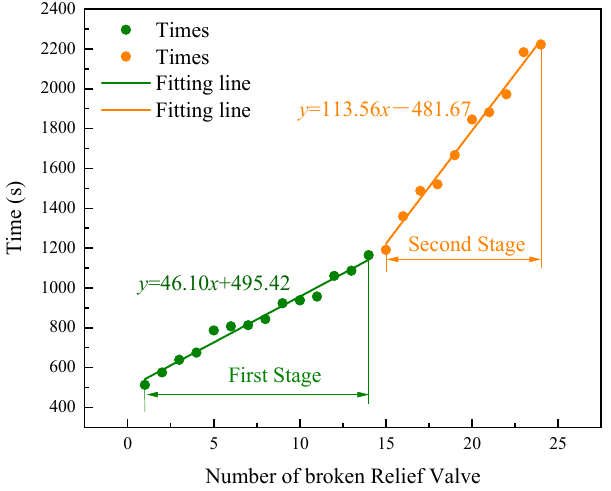
Figure 5. The relationship between the number of broken safety valves and rupturing time.